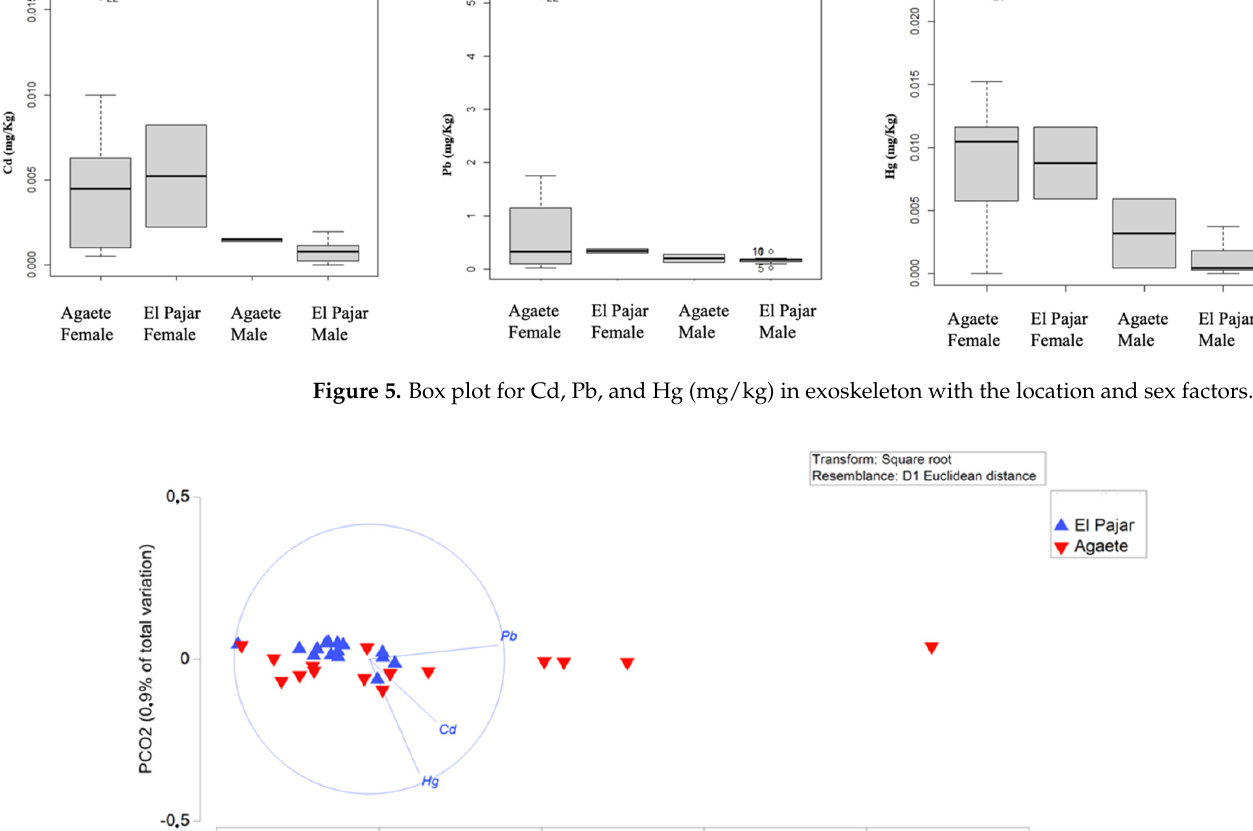
Table 5. PERMANOVA analysis of heavy metals in muscle tissue and exoskeleton with the location factor and type of sample.